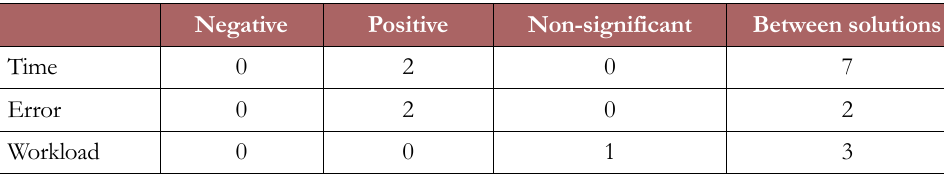
Table 5. Impacts of mixed reality on worker’s